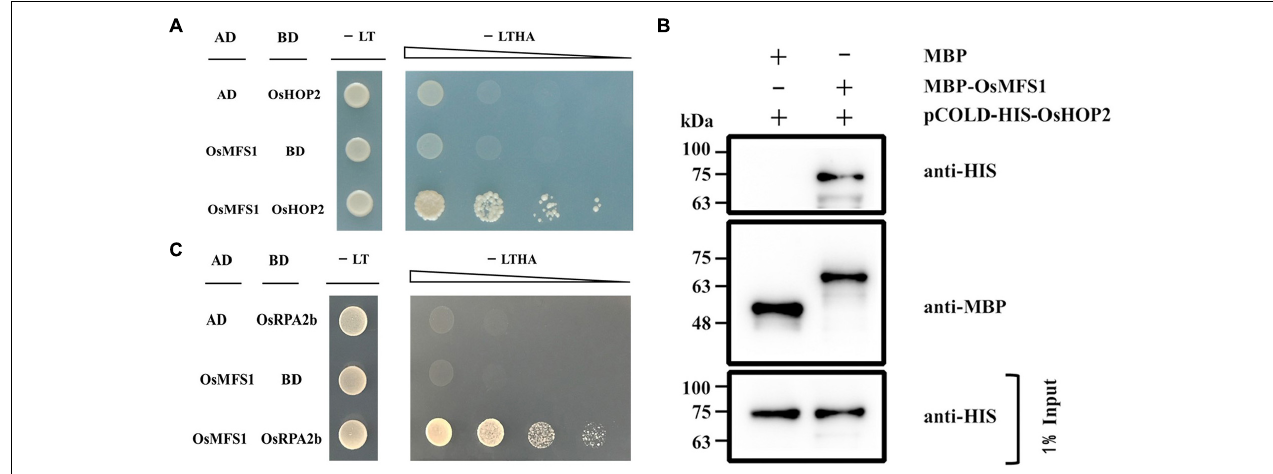
FIGURE 8 | Yeast-two-hybrid (Y2H) assays and in vitro pull-down assay to test interactions of OsMFS1, OsHOP2 , and OsRPA2b. (A) Examination of the interaction between OsMFS1 and OsHOP2 . (B) in vitro pull-down assay was conducted to confirm the interaction between OsMFS1 and OsHOP2 , MBP-MFS1 and pCOLD-His-HOP2 interaction in vitro , but not MBP itself. (C) Examination of the interaction between OsMFS1 and OsRPA2b. The interactions were verified by growing the yeast on the selective medium, Full-length OsMFS1 was inserted in the prey vector pGADT7 (AD). Full-length OsHOP2 and OsRPA2b were cloned into the bait vector pGBKT7 (BD). -LT, selective medium (SD–Leu/–Trp); -LTHA, selective medium